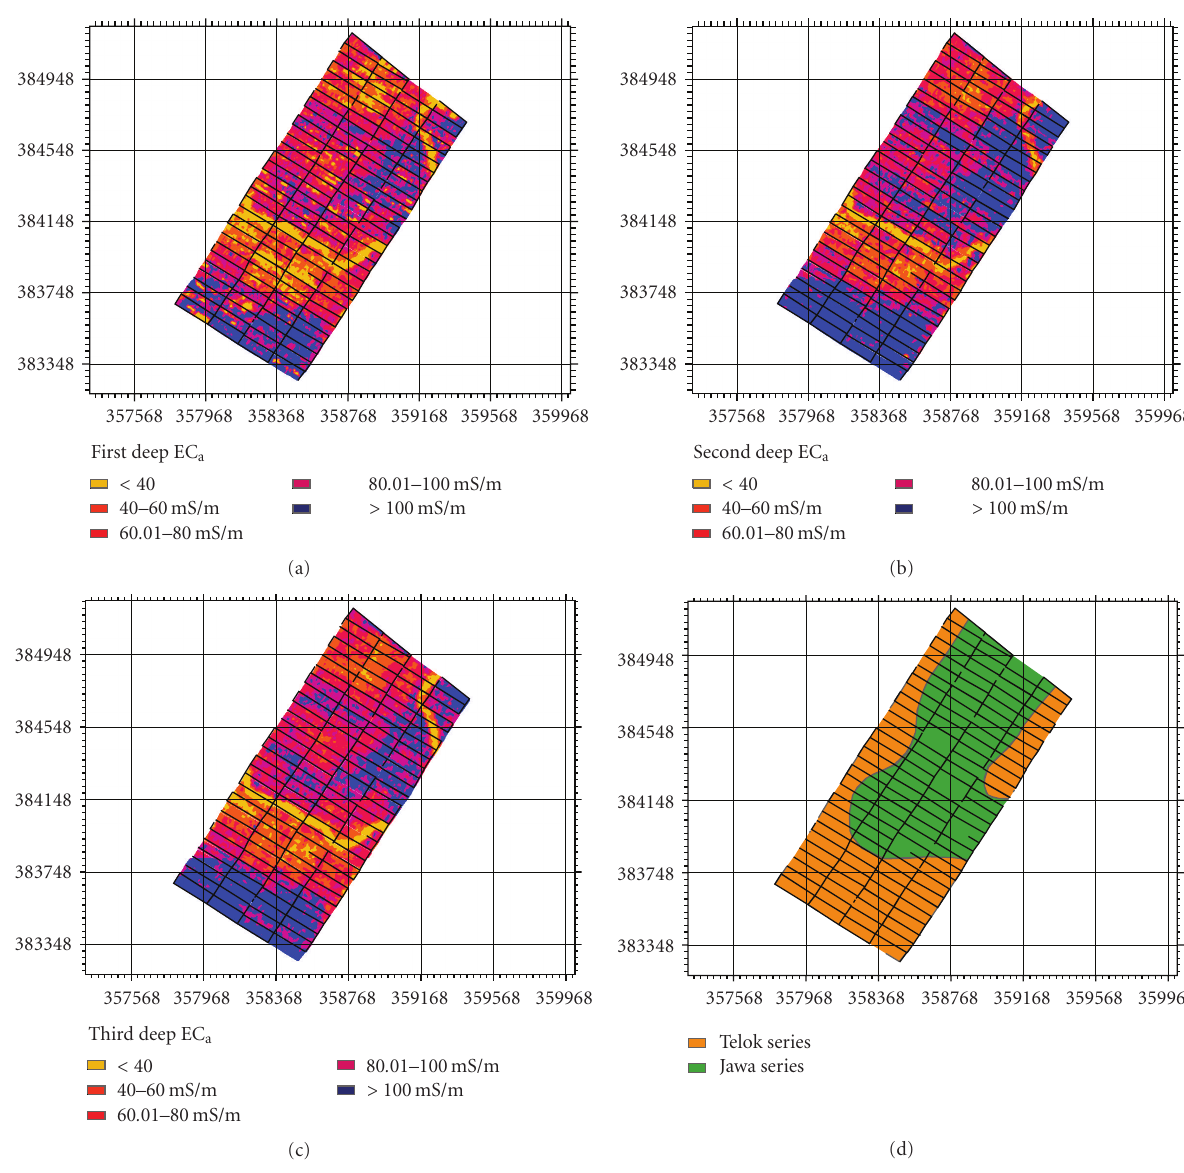
Figure 3: Kriged map for deep EC a (mSm − 1 ) classified by smart quantiles: (a) Season 1, (b) Season 2, (c) Season 3, and (d) Soil series map.